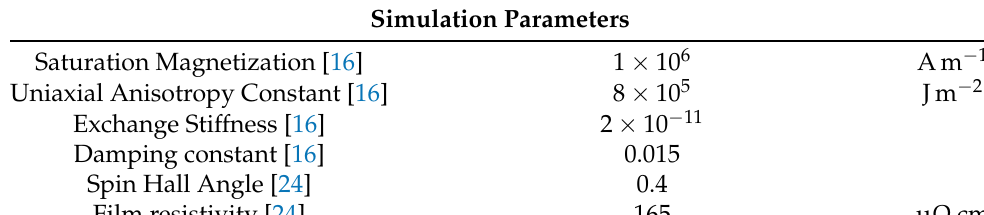
Table 1. Parameters used for micromagnetic simulations and current distribution computation.